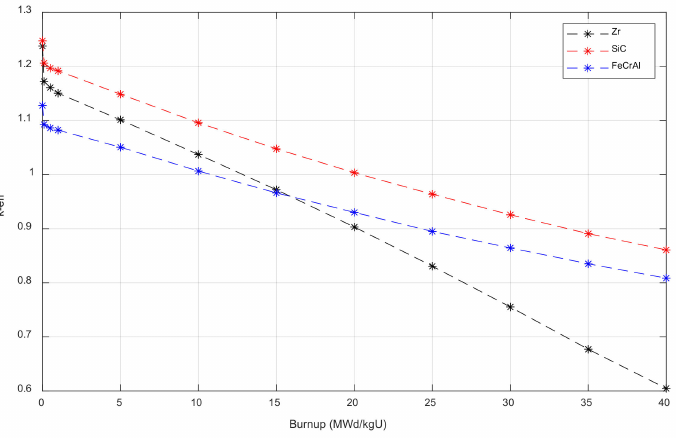
Figure 8. B0 effective multiplication factor versus burnup days for the three cladding